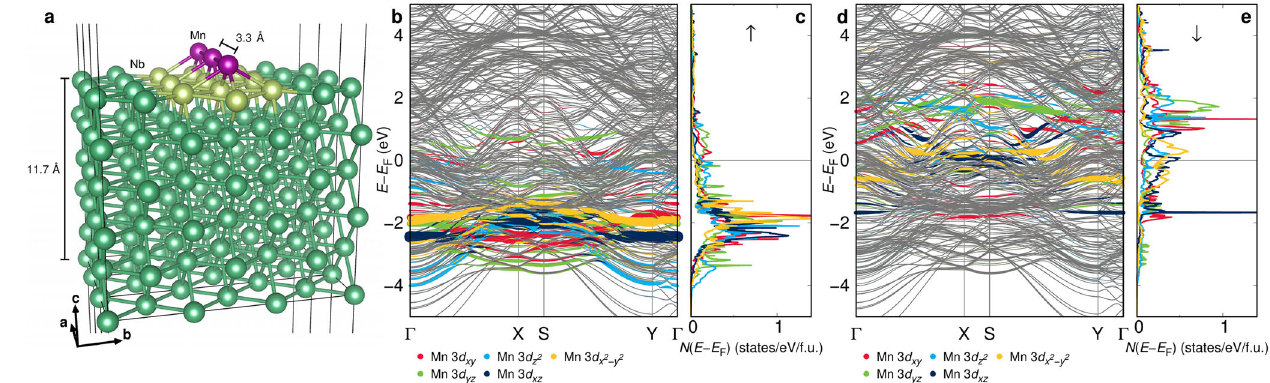
Fig. 1 Ab initio treatment of a Mn chain on the (110) surface of Nb. a Three unit cells used for the DFT calculations are shown; each unit cell contains 36 Nb and one Mn atom. The unit cell is oriented such that a ∣∣ x , b ∣∣ y and c ∣∣ z , and on the Nb surface, a ∣∣ [001], b jj½ 110 (cid:3) . b , d DFT band structure for spin up and down, respectively, where the orbital character of the Mn d -orbitals is highlighted in color while all other orbitals are shown in gray. c , e Density of states (DOS) for the Mn d -orbitals from ( b , d ). Comparison of c and e clearly reveals the spin